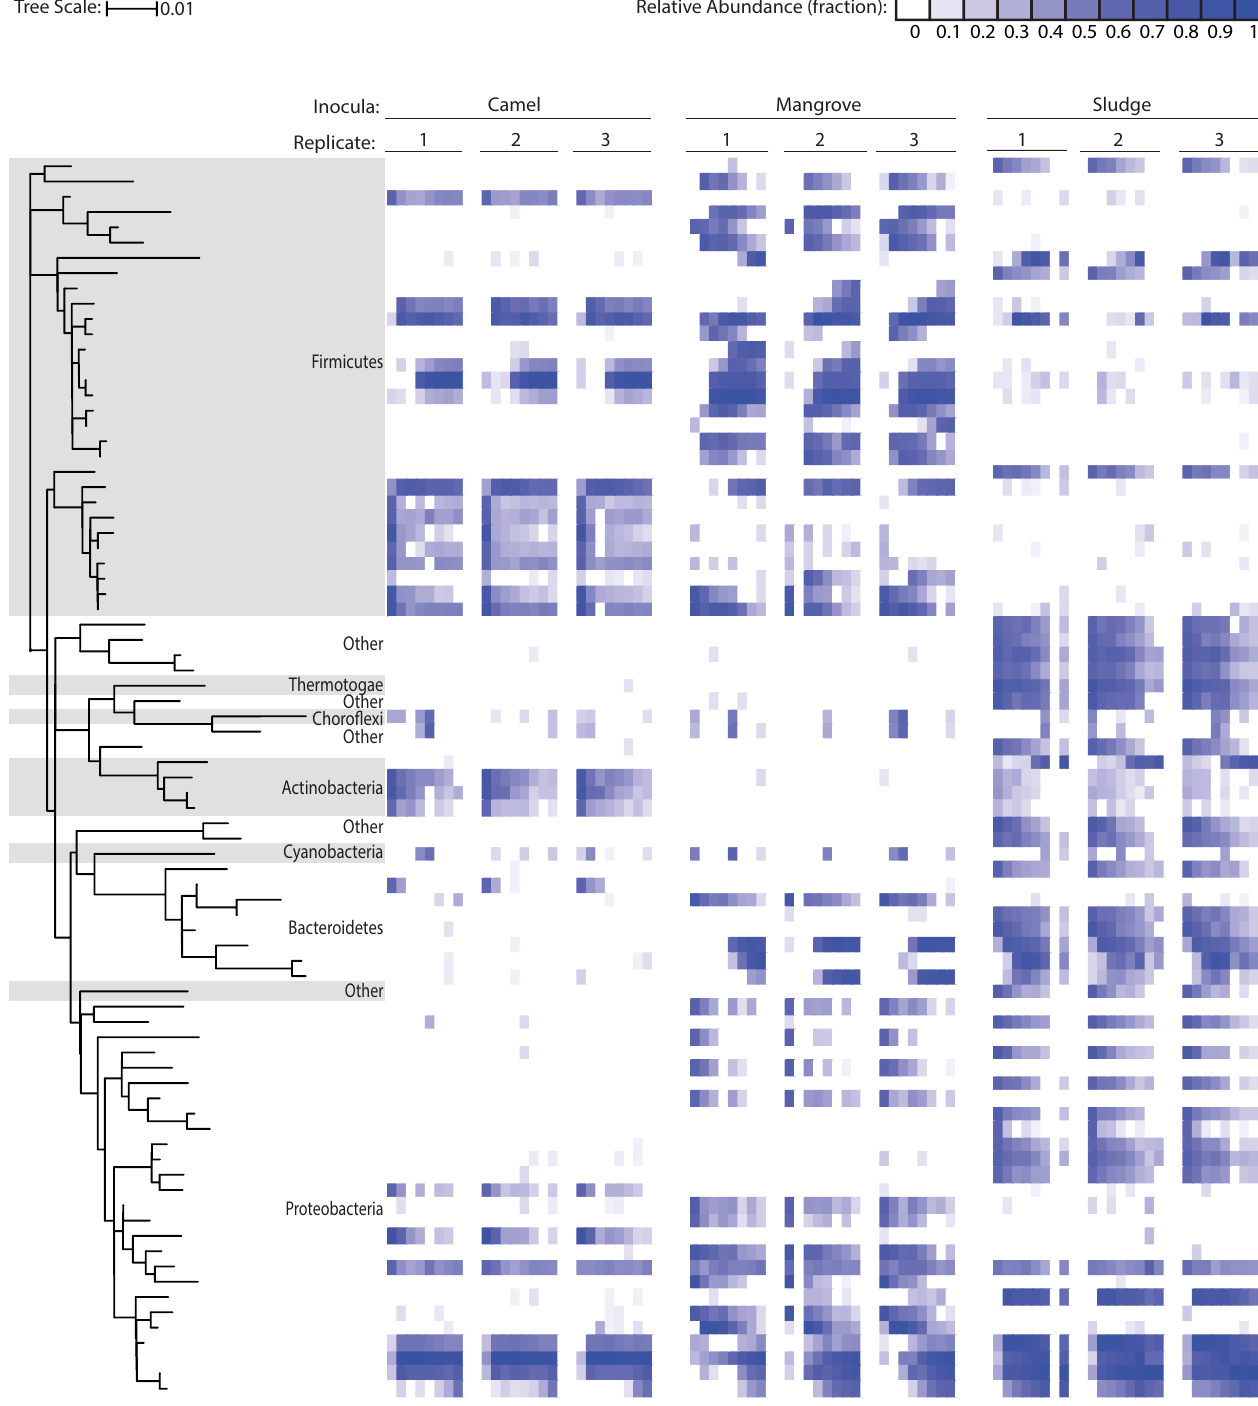
Fig 2. Microbial communities are reproducible and distinct to the initial microbial inoculum. Relative abundancesof OTUs are represented as log relative abundances. Only OTUs that were present at equal or greater than 1% across all time points have beenincluded.OTUs are organized vertically by phylogenetic relationship and horizontallyby time point within a replicate,cycle 0 to cycle